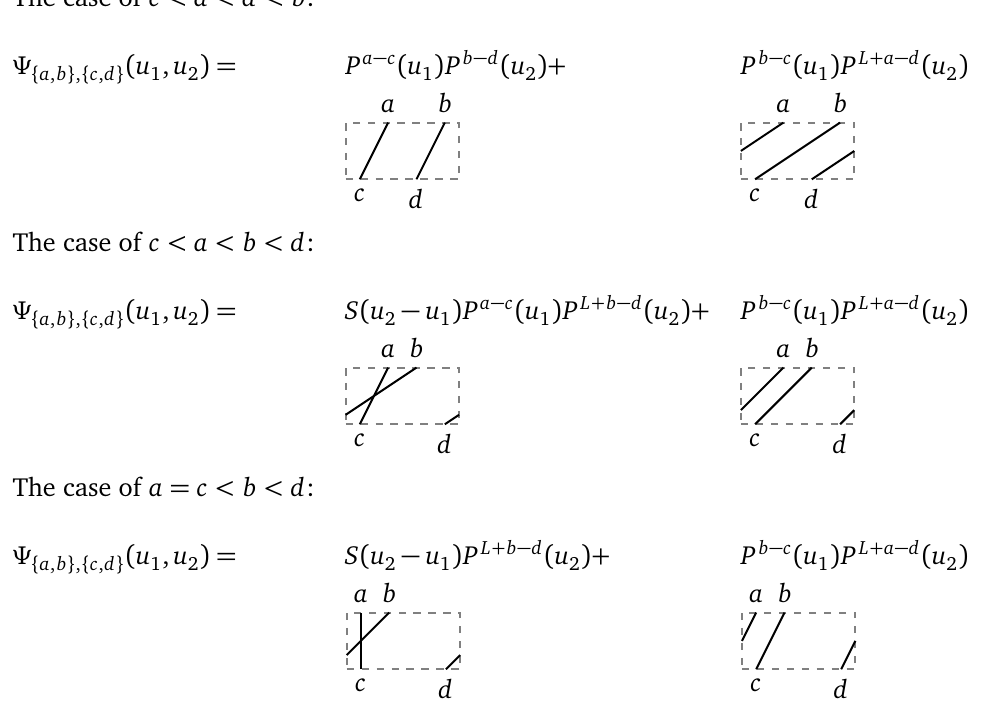
Figure 5: A pictorial interpretation for the amplitude Ψ { ferent cases. The particles 1 and 2 start from the initial positions c and d , respectively, and the amplitude is given by two terms corresponding to the two possibilities of oc- cupying the final positions a and b . The propagation phases are obtained by counting the number of sites that the particles move to the right. A scattering phase S ( u is added when there is a crossing of the